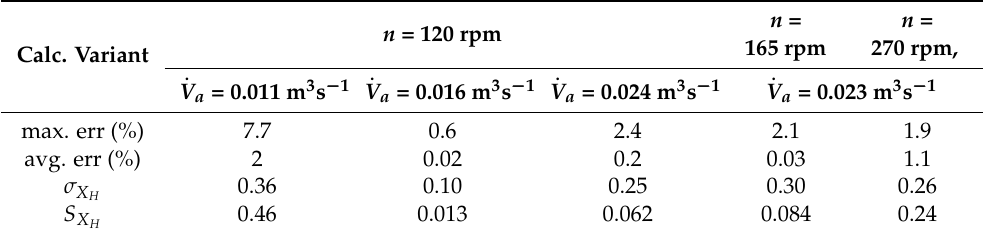
Table 2. Accuracy of honey moisture determination for the adopted dehydrator calculation model.